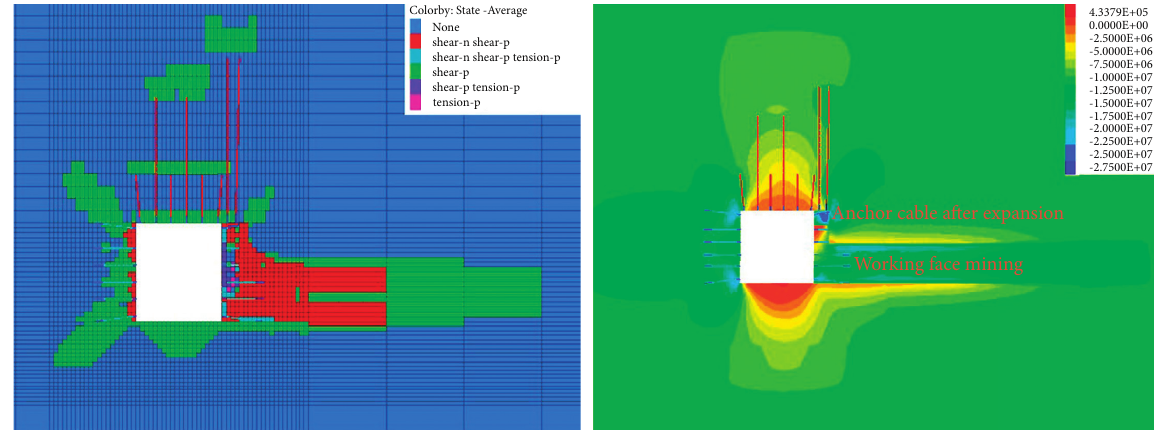
Figure 7: Distribution of the plastic zone and stress at the top corner of the end during mining after cutting and reinforcing anchor cables.